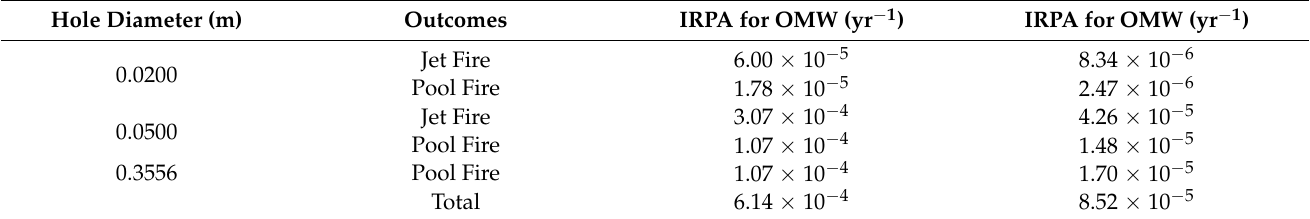
Table 9. Individual risk per annum for operation and maintenance, and administrative workers.